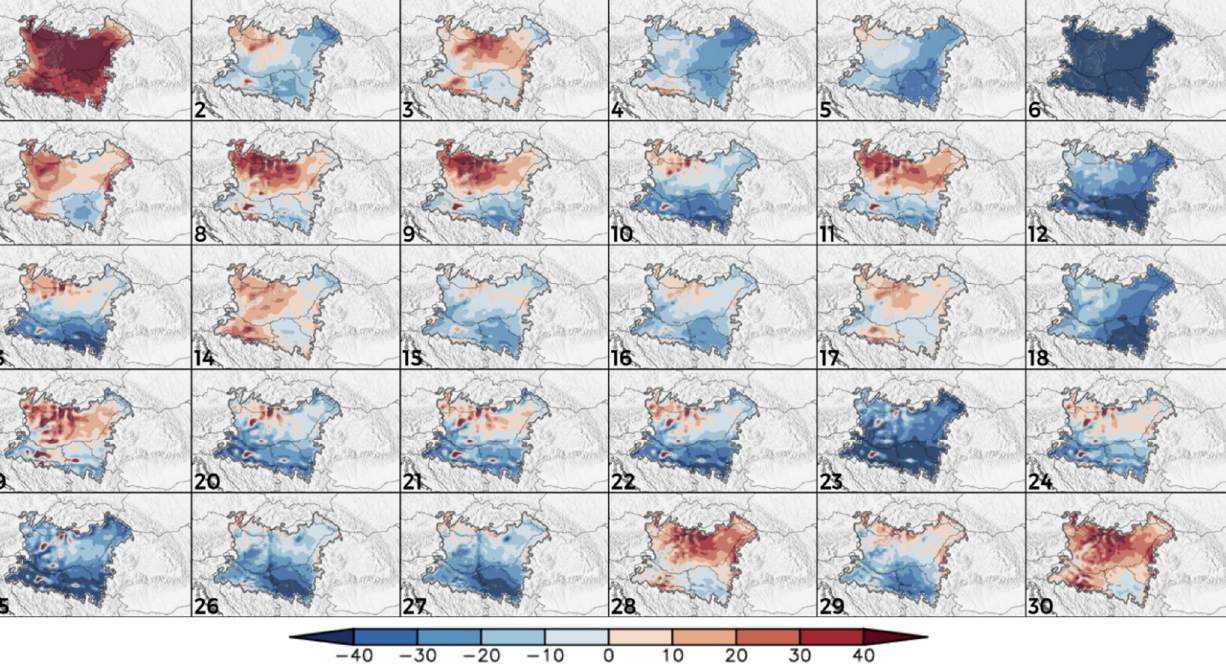
Figure 5. Mean (1971–2000) summer GCM–RCM bias of the mean precipitation field compared with the E-OBS gridded dataset. Biases are expressed as % of observations. The integration numbers follow the list from Table 1.